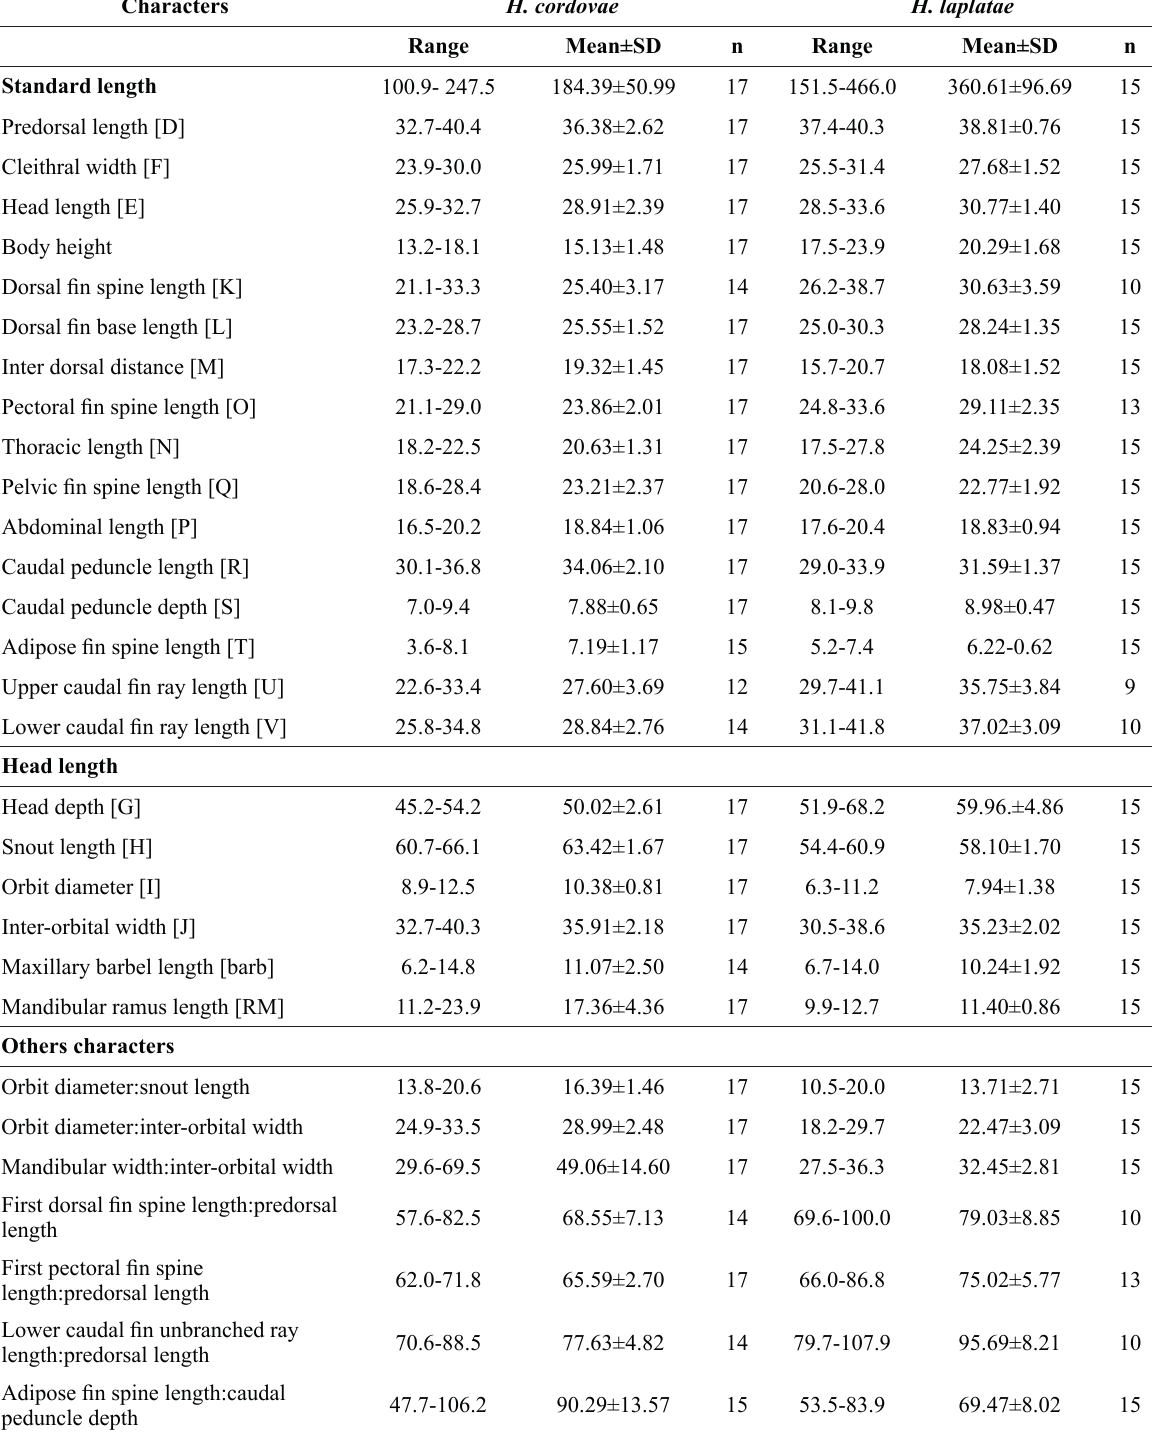
Morphometric and meristic data of Hypostomus cordovae and H. laplatae . Range, mean (or mode for the meristic data), standard deviation (SD) and number of specimen (n). Morphometric and meristic variables used in the BCA analysis (Figs. 3) are showed with abbreviations in